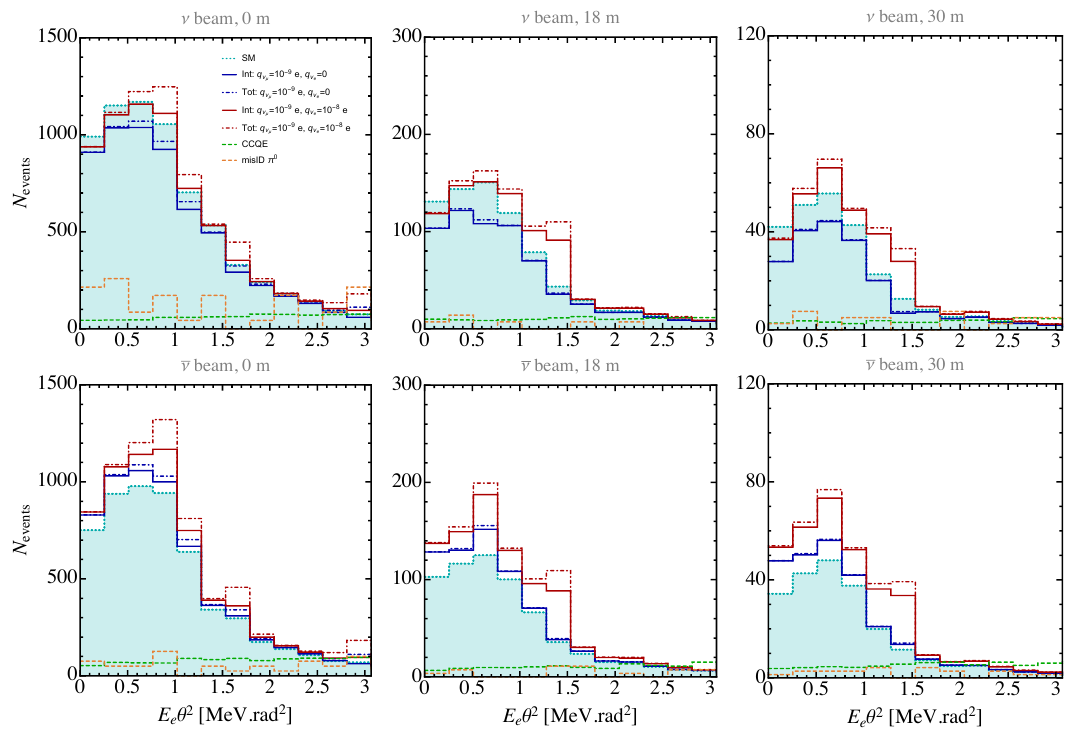
Figure 5 . This is the neutrino milli-charge version of figure 2, with the exception that here the BSM contributions are broken into an interference (Int) and total (Tot) contributions. The dark blue curves (dark red) correspond to milli-charge q ν solid (dashed) curves denote to the interference (total) number of events. See the text for